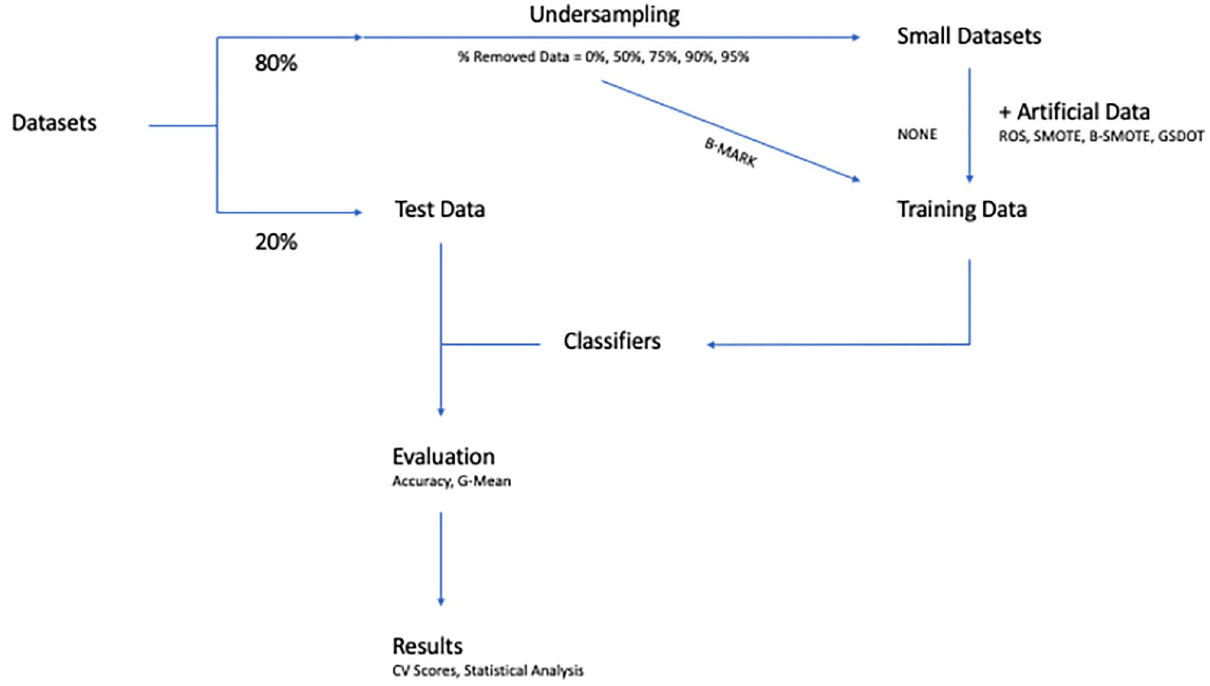
Fig 3. Visualization of the experimental